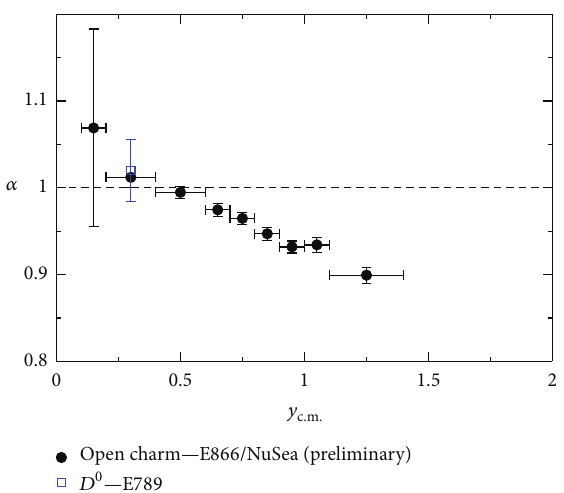
Figure 6: The rapidity dependence of open charm production in 𝑝𝐴 collisions at 800GeV, parametrized in the form 𝜎